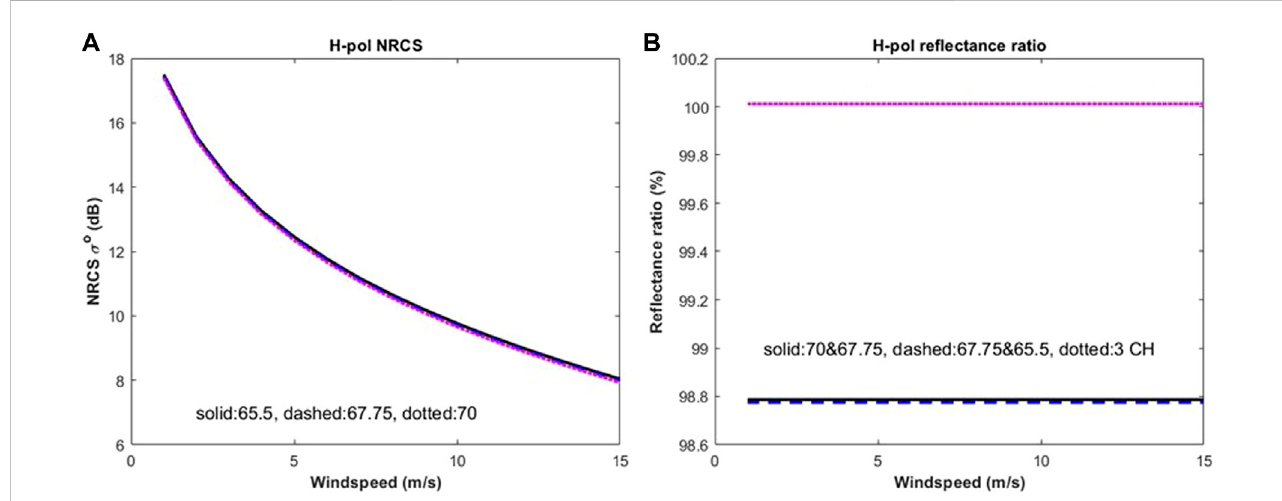
FIGURE 3 VariationsofsimulatedH-polNRCS (A) andre fl ectanceratio (B) withseasurfacewindspeed. Thecurvestyle/color codeisthesameasthoseinFigures1,